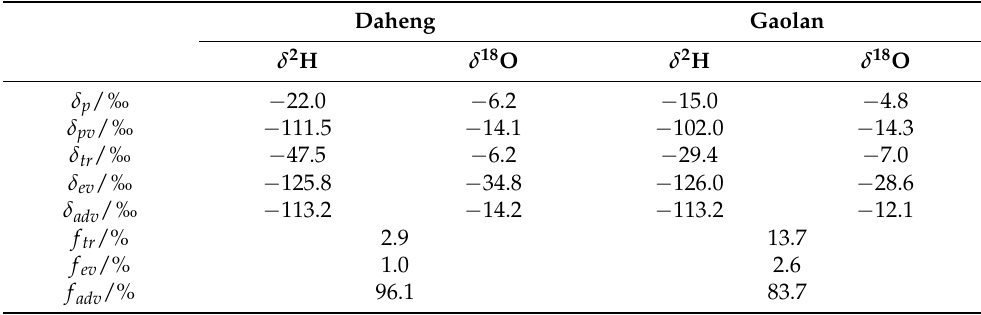
The isotope values of precipitating vapor at Yongdeng are estimated as 2 δ pv = − 111.9‰ and 18 δ pv = − 14.1‰. A similar procedure was applied to Daheng and Gaolan, respec- tively, and the isotope values in precipitating vapor at Daheng ( 2 δ pv = − 111.5‰, and 18 δ − 14.1‰) and Gaolan ( 2 δ − 102.0‰, and 18 δ − 14.3‰) are slightly depleted pv = pv = pv = relative to the upwind station Yongdeng. The stable isotope ratios in advection vapor at Daheng and Gaolan are listed in Table 3. Proportions of advected and recycled water vapor over the path of Yongdeng– Daheng/Gaolan in